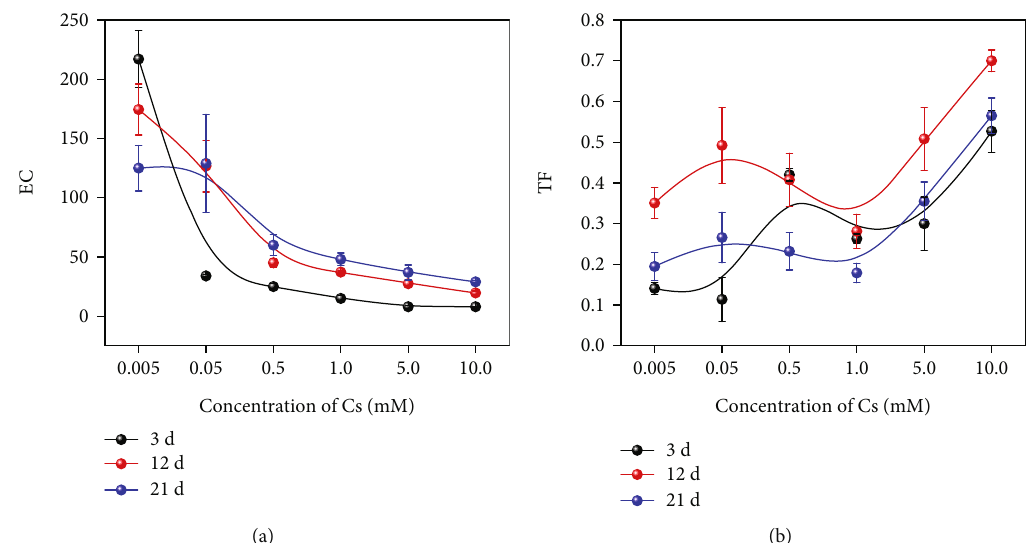
Figure 6: Comparison of enrichment coe ffi cient (EC) and transfer factors (TF) at six di ff erent Cs + concentrations and sampling days ( n = 3 individual